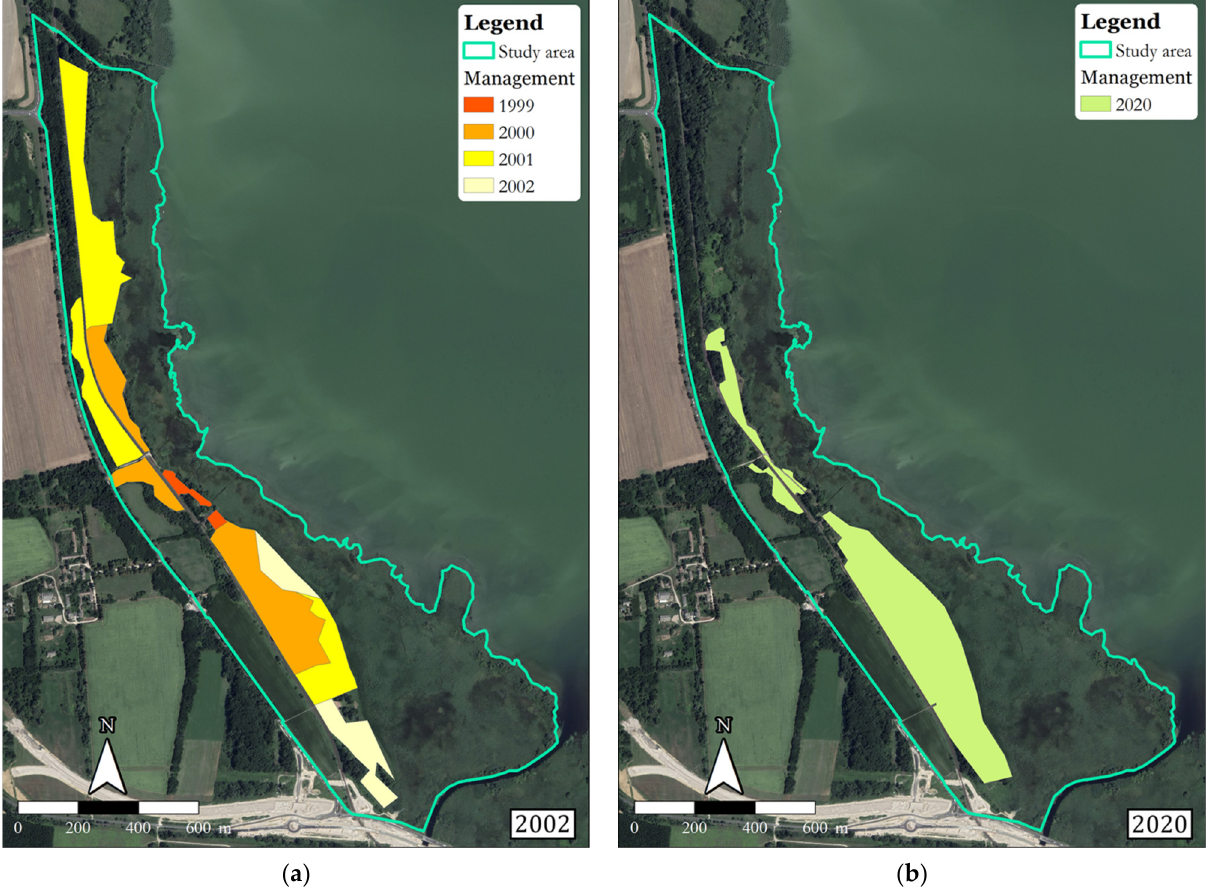
Figure 2. Areas under conservation management (cutting and grazing) in four subsequent years from 1999 to 2002 ( a ) and in 2020 ( b ).